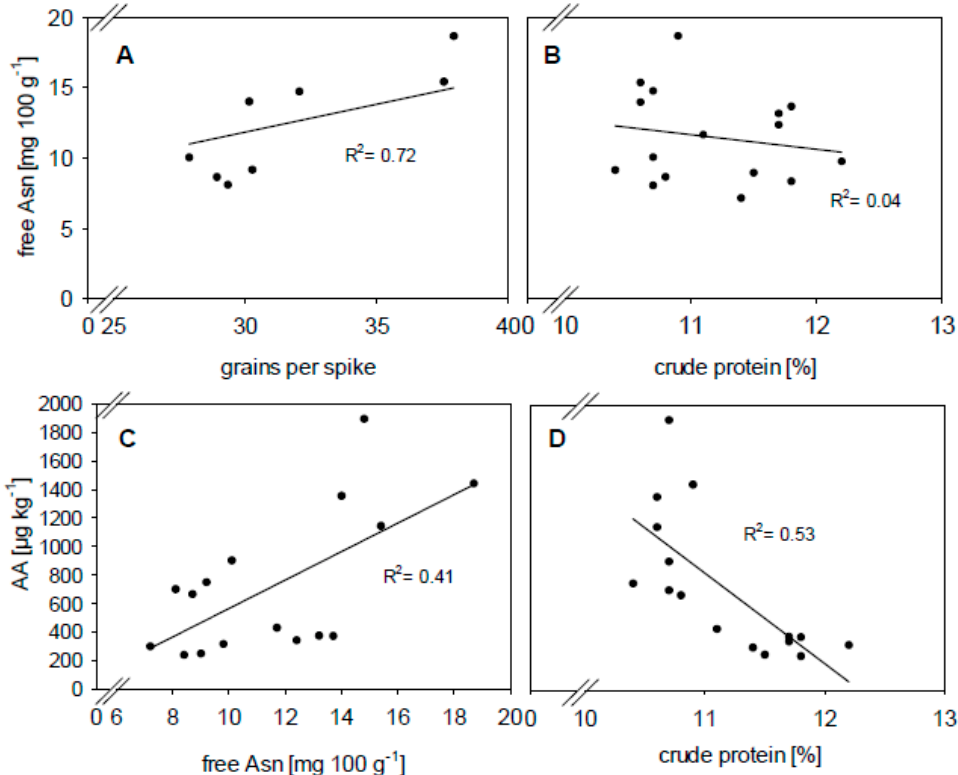
Figure 3. Relation of the traits free Asn * grains per spike ( A ), free Asn * crude protein ( B ), AA * free Asn ( C ) and AA * crude protein ( D ) in flours of wheat cultivars across years and treatments.